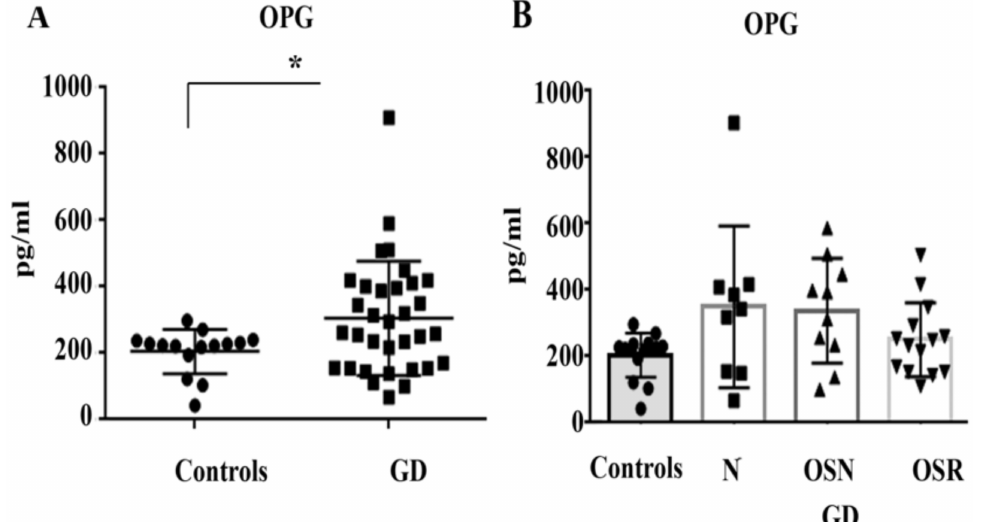
Figure 4. Plasma OPG (osteoprotegerin) concentrations. ( A ) OPG level, control (mean 206 ± 17, n = 10) vs. GD (mean 307 ± 30, n = 33). * p < 0.05 unpaired t test and F test. ( B ) OPG concentrations in control subjects and GD with no bone complication (N), osteopenia (OSN), and osteoporosis